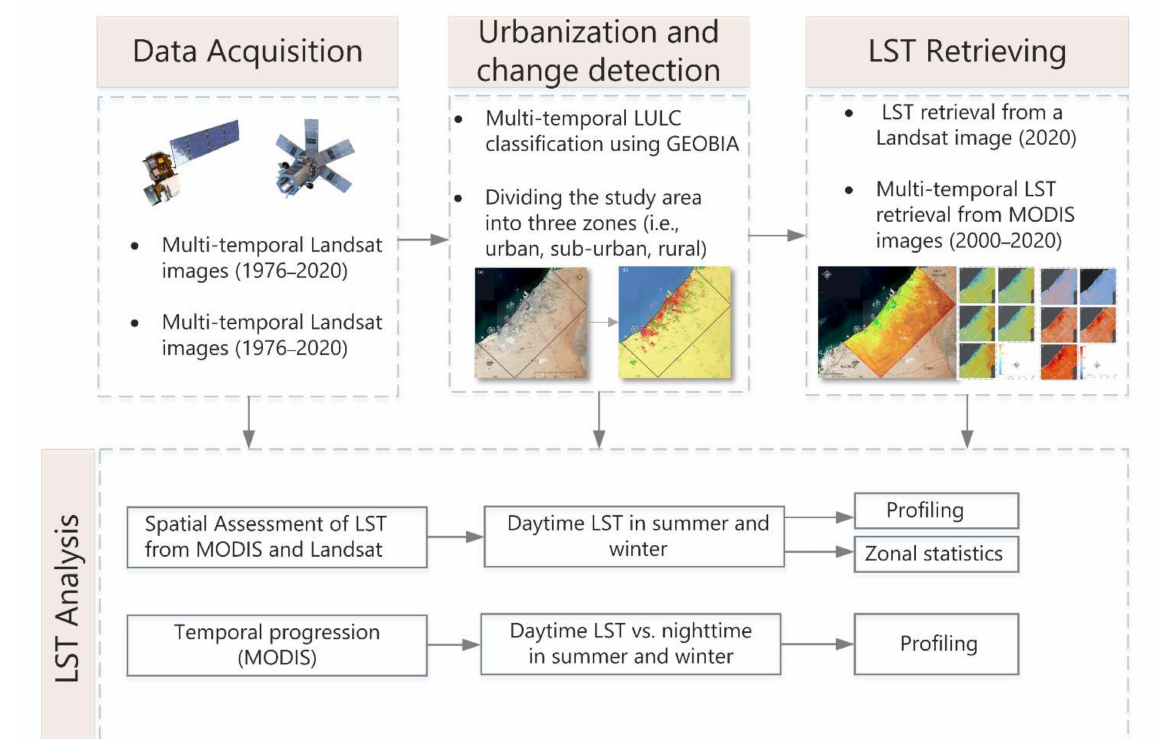
Figure 1. Methodology